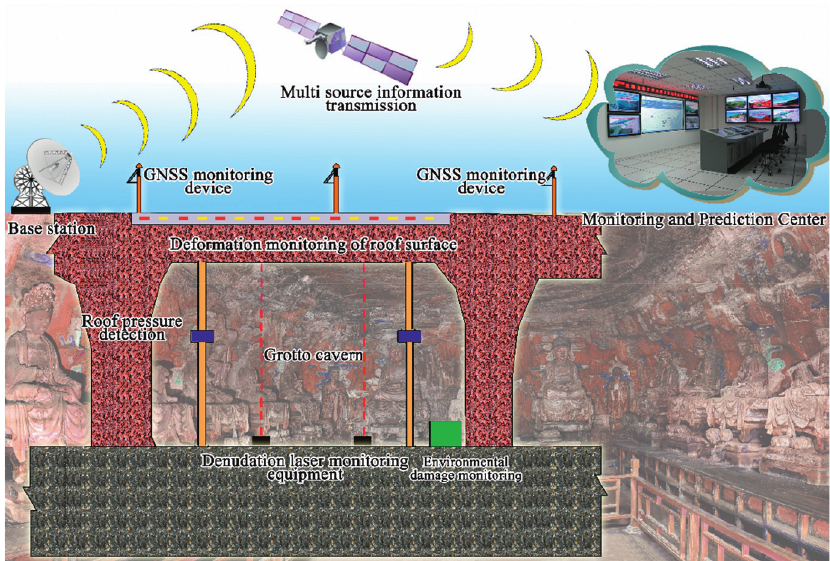
Figure 5: Schematic diagram of the integrated monitoring system.